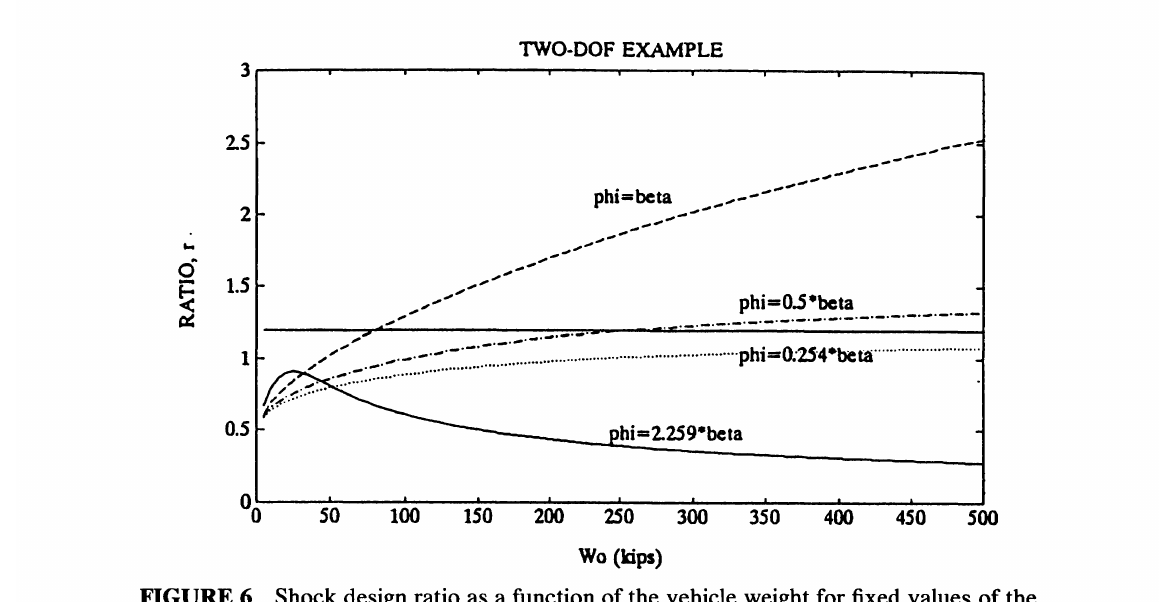
FIGURE 6 Shock design ratio as a function of the vehicle weight for fixed values of the vehicle frequency